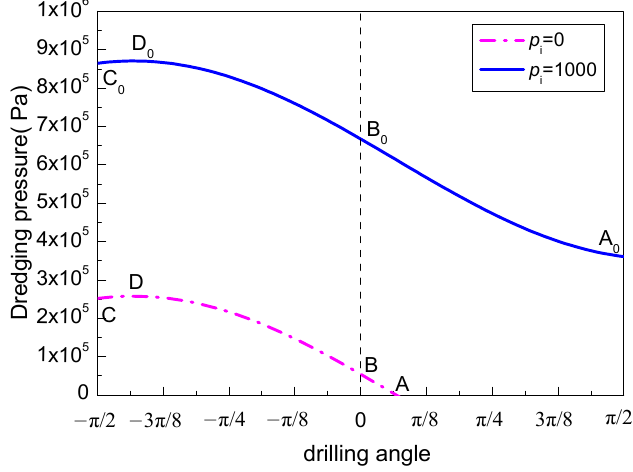
Figure 7. Curves of the relationship between the dredging pressure and the drilling angle.